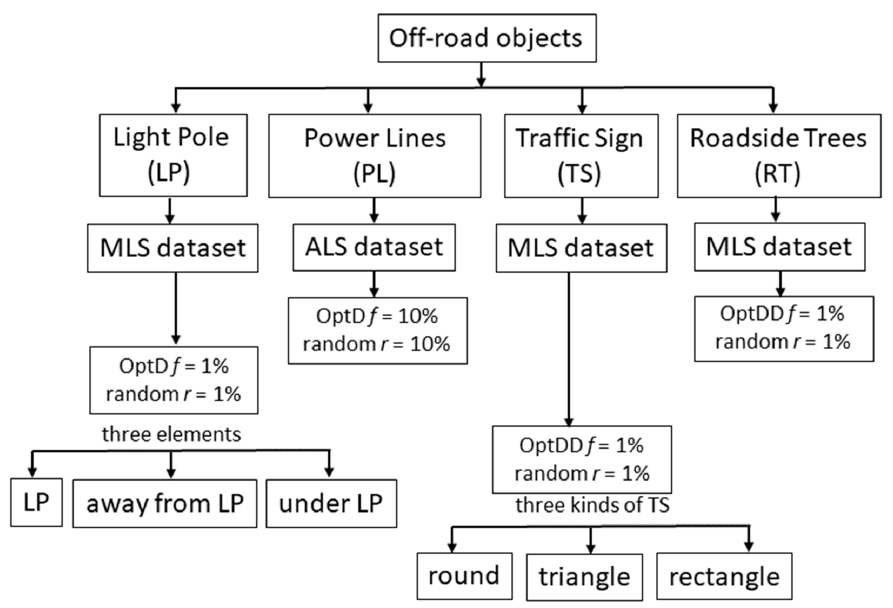
Figure 1. Scheme of the workflow . MLS: Mobile Laser Scanning; ALS: Airborne Laser Scanning.